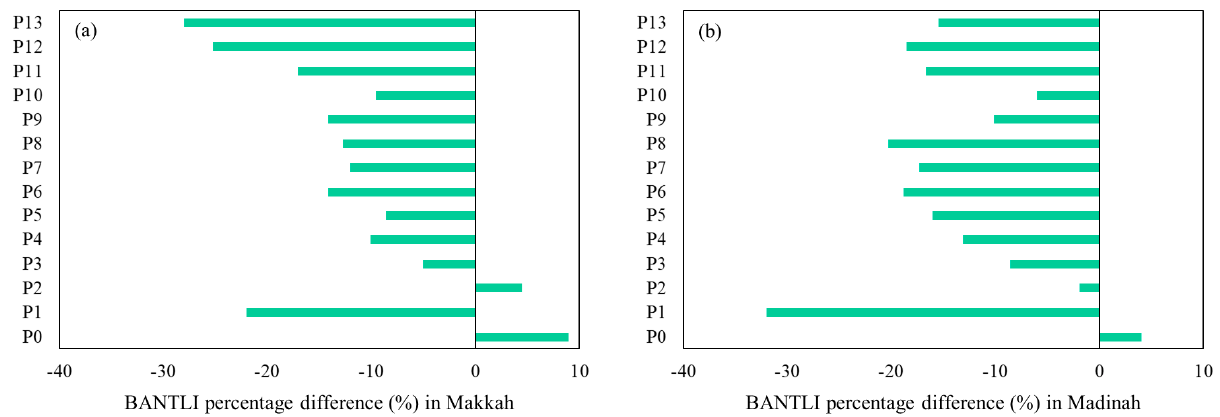
Figure 7. BANTLI percentage differences in ( a ) Makkah and ( b ) Madinah for the pre-pandemic (P0), pandemic (P1) and post-pandemic (P2 to P13) periods at the city level.